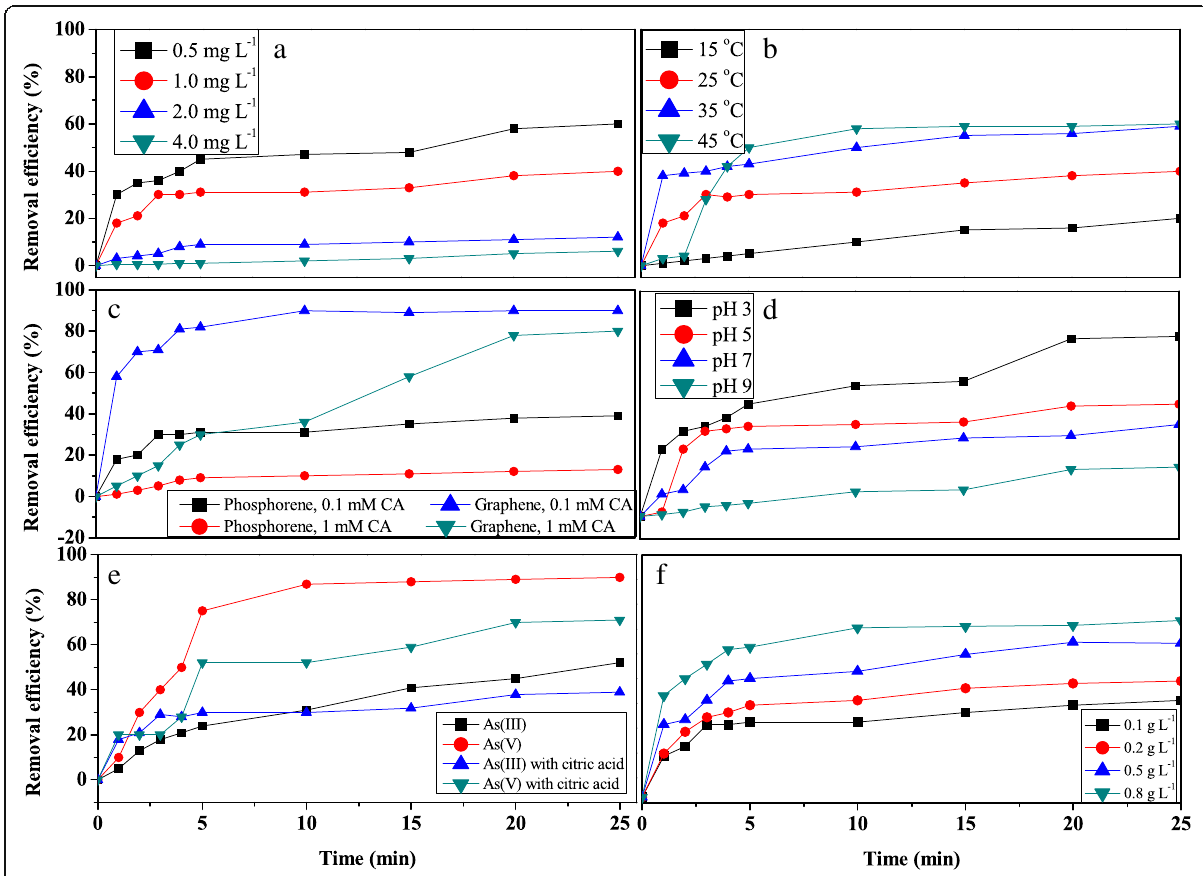
Fig. 4 Effects of environmental parameters on performance ( a ) Concentration, ( b ) Temperature, ( c ) CA concentration, ( d ) pH, (e) Valance, ( f ) Dosage. Conditions: initial As(III) or As(V) concentration = 1.0 mg L − 1 ; solution temperature = 25 °C; pH = 7.0; concentration of CA = 0.1